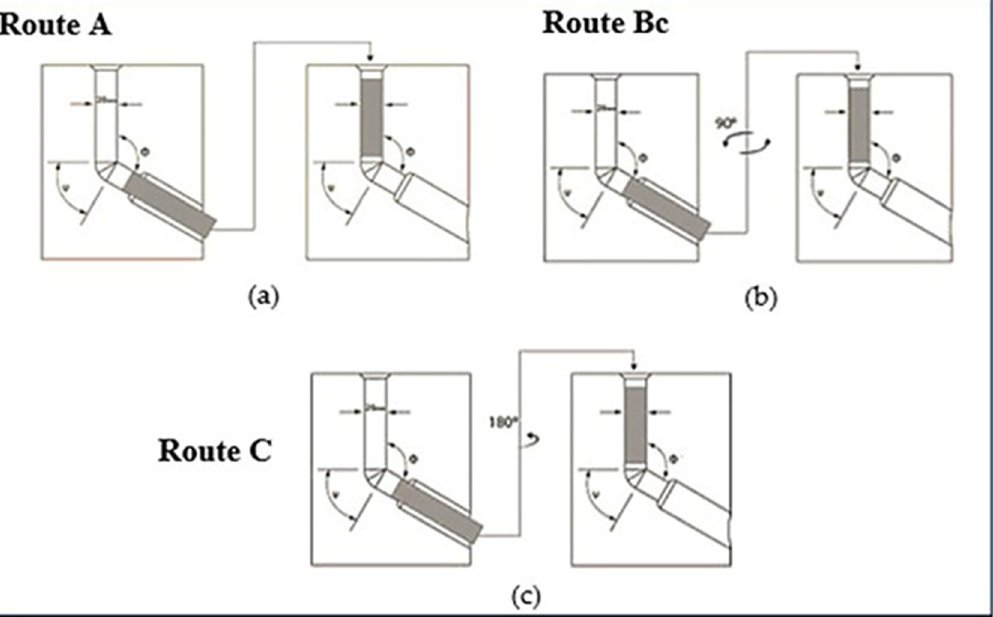
Figure 1. Schematic of the different routes of ECAP through multiple passes; ( a ) route A, ( b ) route Bc, and ( c ) route C.